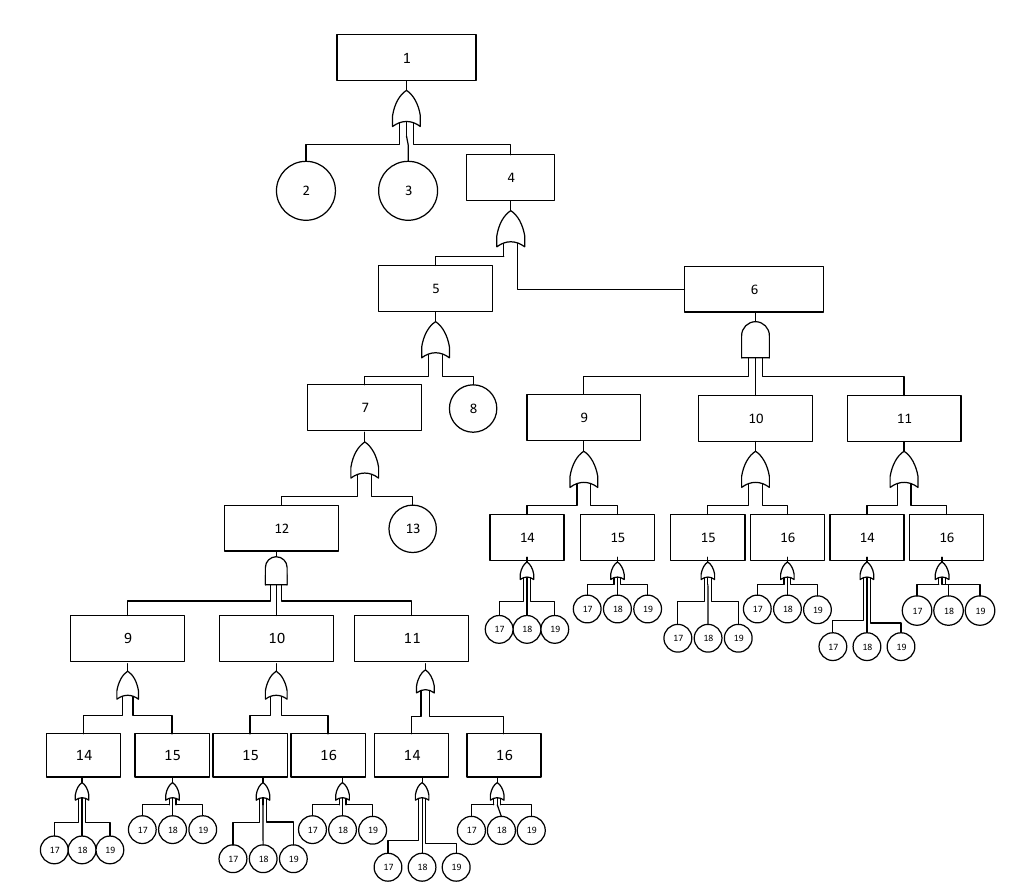
Figure A1. Fault tree of reactor scram failure activated by pool water-level signal. Note: 1 = reactor fail to scram. 2 = control rods insertion fail (B1). 3 = contact 6 system fail (B2). 4 = no signal. 5 = no scram manually. 6 = no scram from automatic system. 7 = the operator does not receive an alarm. 8 = operator fail (B7). 9 = detector system of JAA-01 CL 811 and 821 fail. 10 = detector system of JAA-01 CL 831 and 821 fail. 11 = detector system of JAA-01 CL 811 and 831 fail. 12 = detector system fail. 13 = alarm fail (B3). 14 = detector system of JAA-01 CL 811 fail. 15 = detector system of JAA-01 CL 821 fail. 16 = detector system of JAA-01 CL 831 fail. 17 = detector fail (B4). 18 = transmitter fail (B5). 19 = buffer fail (B6).